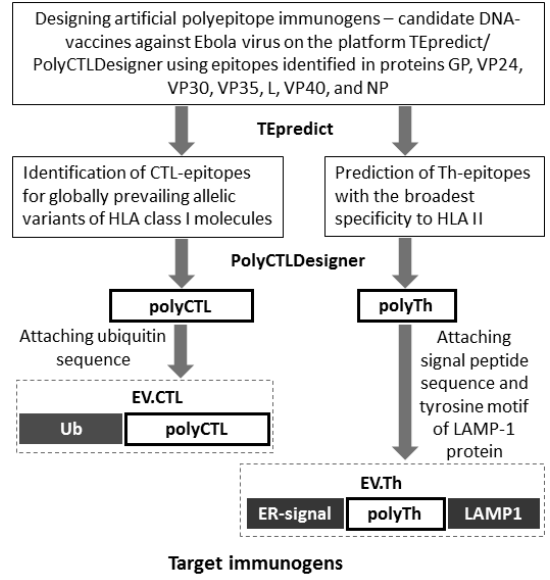
Figure 1. Designing artificial polyepitope antigens of Ebola virus.